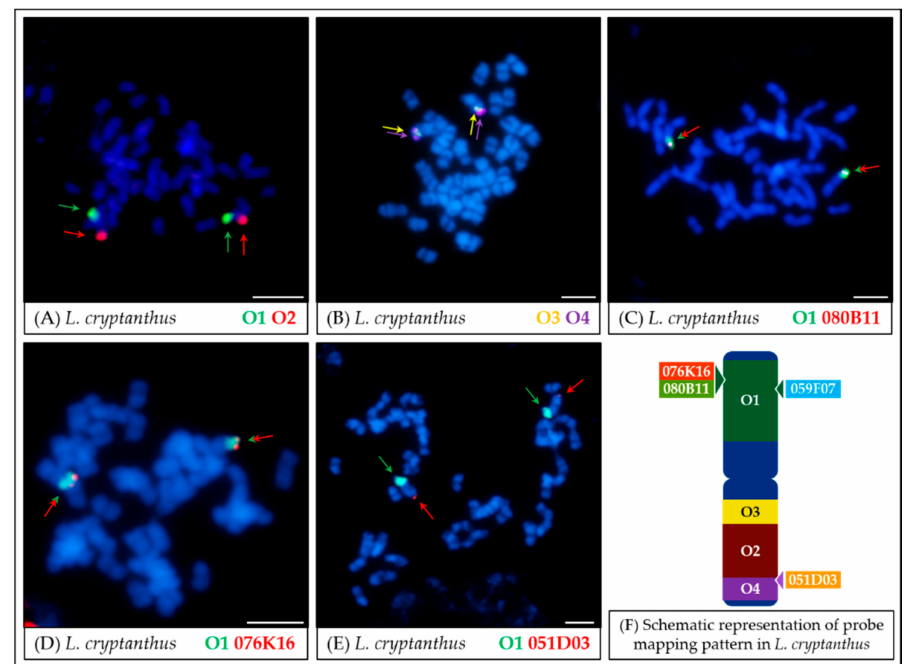
Figure 4. FISH mapping of oligonucleotide probes ( A , B ) and oligonucleotide combined with BAC clones ( C – E ) on mitotic metaphase chromosomes of L. cryptanthus . The positions of individual probes are marked by arrows. Probe colors are as follows: green (O1, Lang06 arm A), red (O2, Lang06 arm B), yellow (O3, pericentromeric region of Lang06 arm B) and purple (O4, telomere region of Lang06 arm B). Scale bar: 5 µ m. Schematic representation of probe mapping pattern in L. cryptanthus chromosomes ( F ), showing observed positions of particular oligonucleotide-based or BAC-based probes, was not drawn to